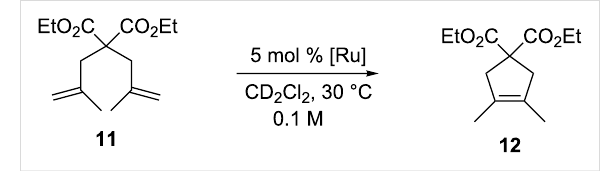
The behavior of this catalyst family was tested in the RCM of diethyl diallylmalonate ( 7 , Scheme 1) and compared with that of GII-SIMes and HGII-SIMes .